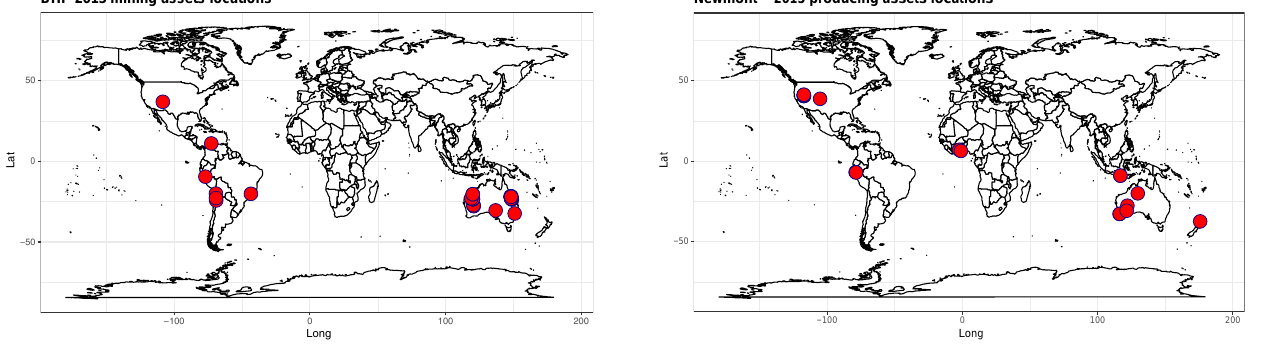
Figure A3. Map of Newmont 2015 producing